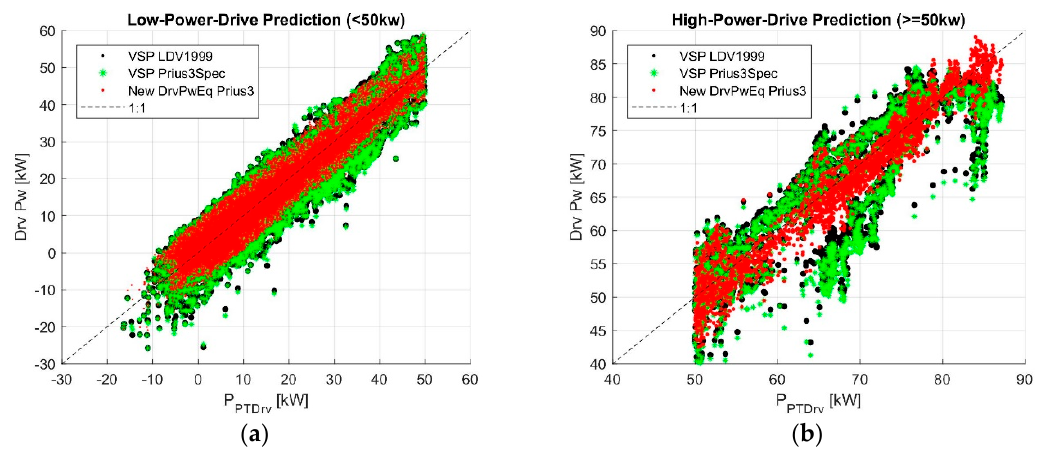
Figure 4. Validation of vehicle driving-power estimations compared to powertrain driving power ( P PTdrv ). ( a ) Light-load driving ( < 50 kW), and ( b ) heavy-load driving ( ≥ 50 kW).